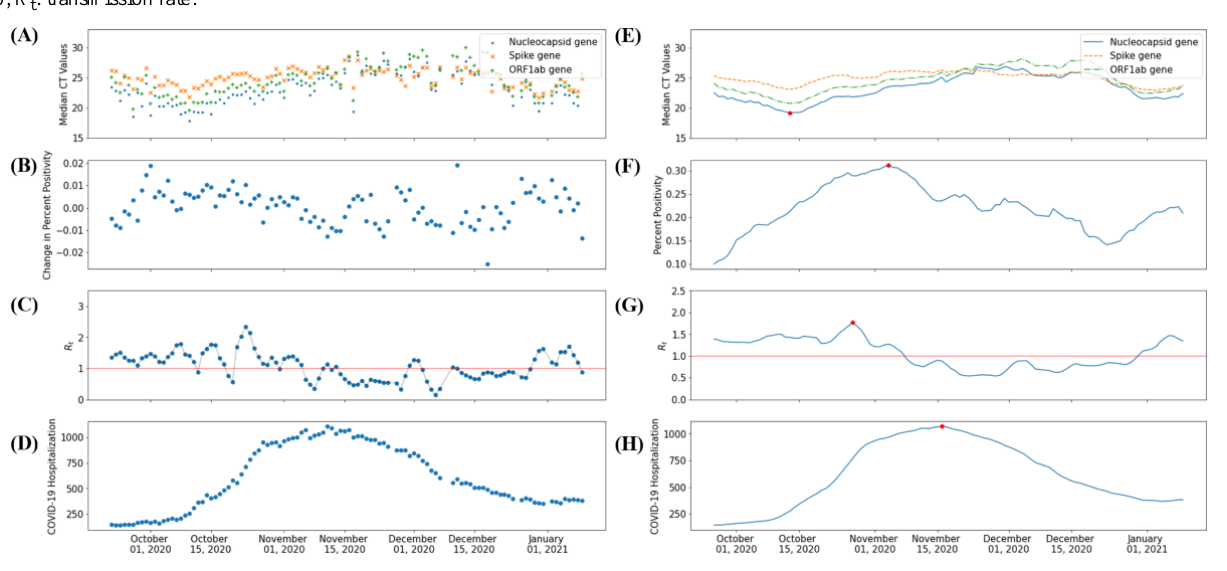
Figure 1. (A) Daily median CT values for SARS-CoV-2 positive samples. (B) Daily change in percent positivity for SARS-CoV-2 detection. (C) Daily SARS-CoV-2 R t . (D) Daily count of hospitalized individuals with COVID-19. (E) The 7-day rolling average of the daily median CT values for SARS-CoV-2–positive samples. (F) The 7-day rolling average of percent positivity rates for SARS-CoV-2–positive samples. (G) The 7-day rolling average of daily SARS-CoV-2 R t values. (H) The 7-day rolling average of the number of hospitalized individuals with COVID-19 in the greater El Paso area between September 15, 2020, and January 11, 2021. The red lines in graphs C and G signify an R t value of 1. Red dots represent the global minimum for smoothed CT values and global maxima for smoothed epidemiological indicators. CT: cycle threshold; ORF1ab : open reading frames 1ab; R t : transmission